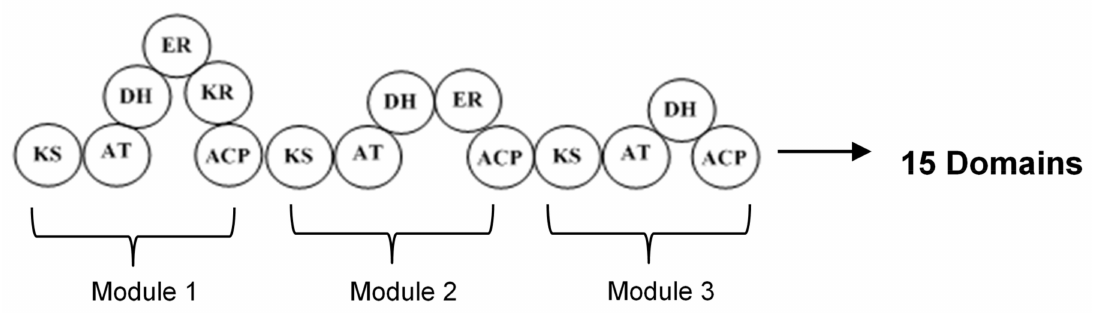
Figure 2. Structure of type I PKSs with three modules and 15 domains. ACP, acyl carrier protein;